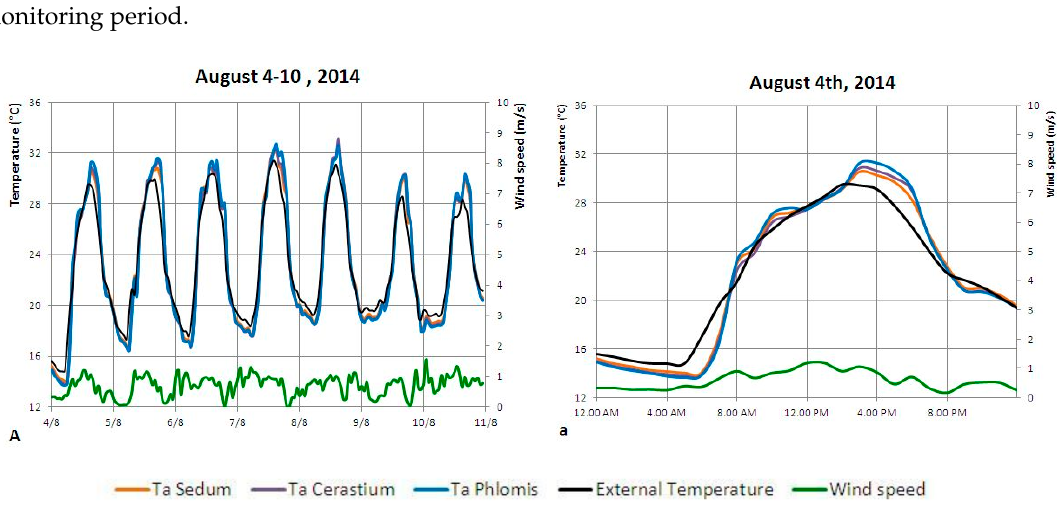
Figure 8. Air temperatures trend (T a ), at a height of 30 cm from the planting surface: ( A ) sample week,